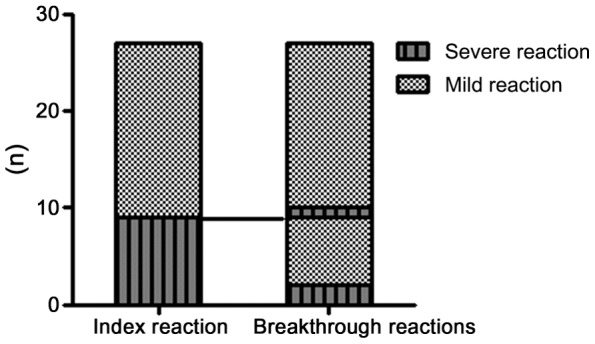
Relationship between the severity of the index and breakthrough reactions under the current system.